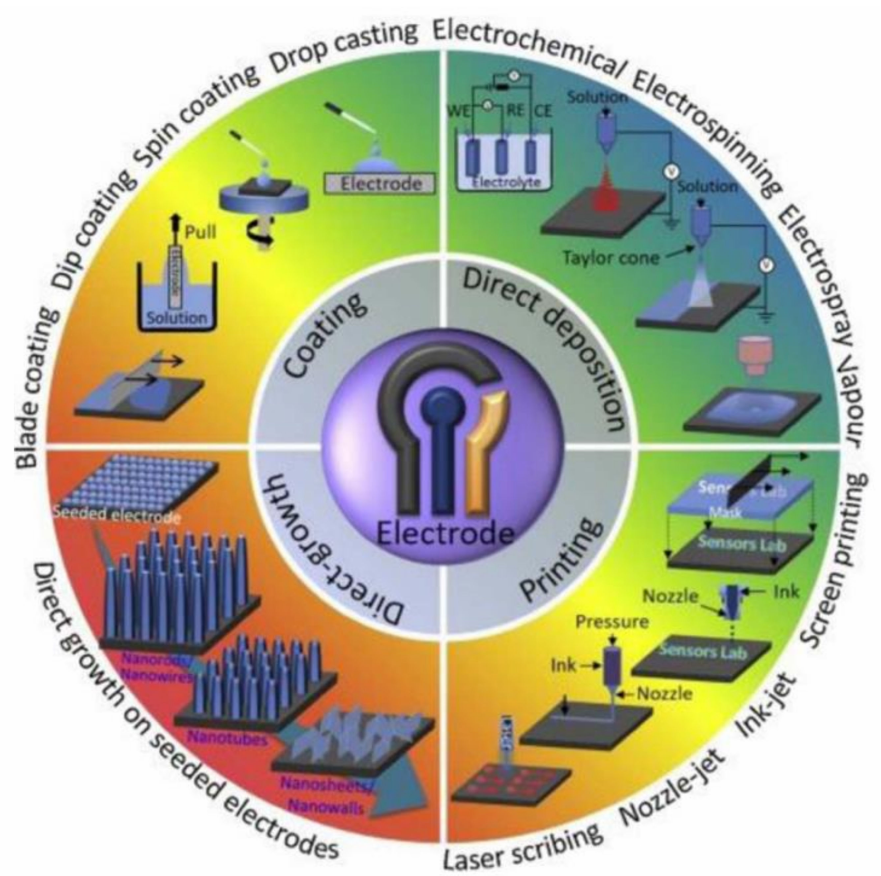
Figure 19. Graphene-modified electrode manufacturing techniques are shown schematically in this dia- gram. (Reproduced from [440] with permission. Copyright 2018, Elsevier, Amsterdam, The